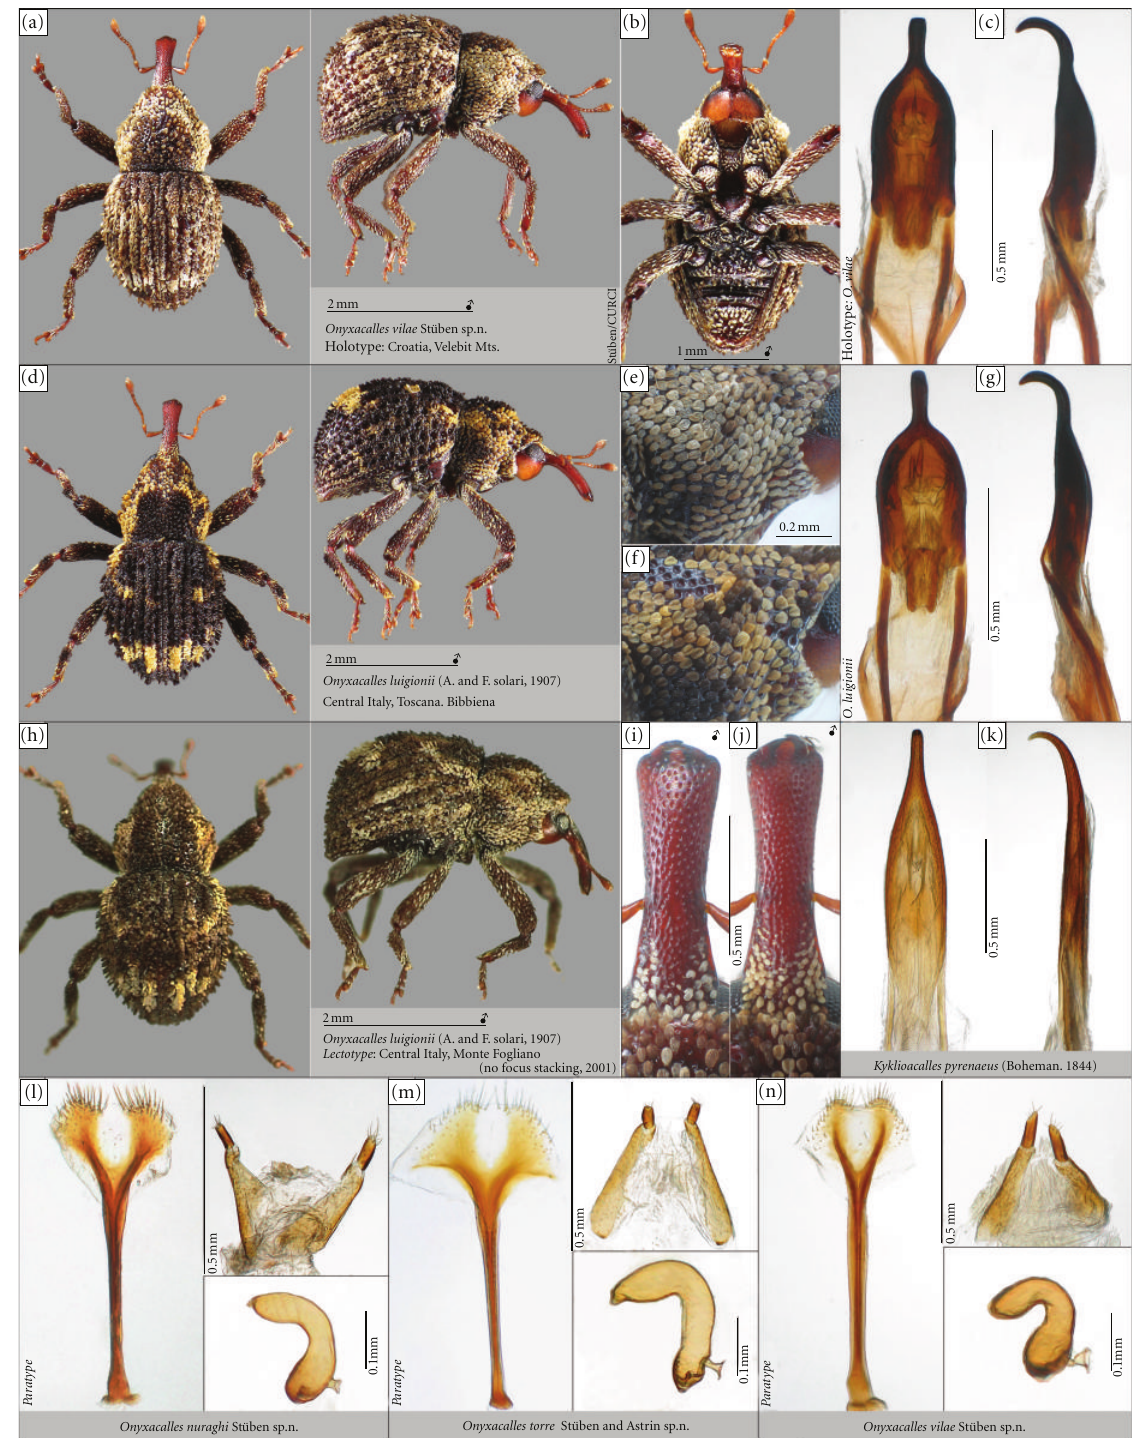
Figure 6: (a–c) O. vilae sp. n.—habitus (dor./lat./ven.), aedeagus (ven./lat.); (d, g) O. luigionii —habitus (dor./lat.), aedeagus (ven./lat.); (h) O. luigionii (lectotype)—habitus (dor./lat.); (k) Kyklioacalles pyrenaeus —aedeagus (ven./lat.); (l–n) female genital (spiculum ventrale, ovipositor, spermatheca) of O. nuraghi sp.n. (l), O. torre (m) and O. vilae (n). By comparison, bristle of pronotum (lat.)— O. vilae (e) versus O. luigionii (f); rostrum— O. vilae (j) versus O. luigionii